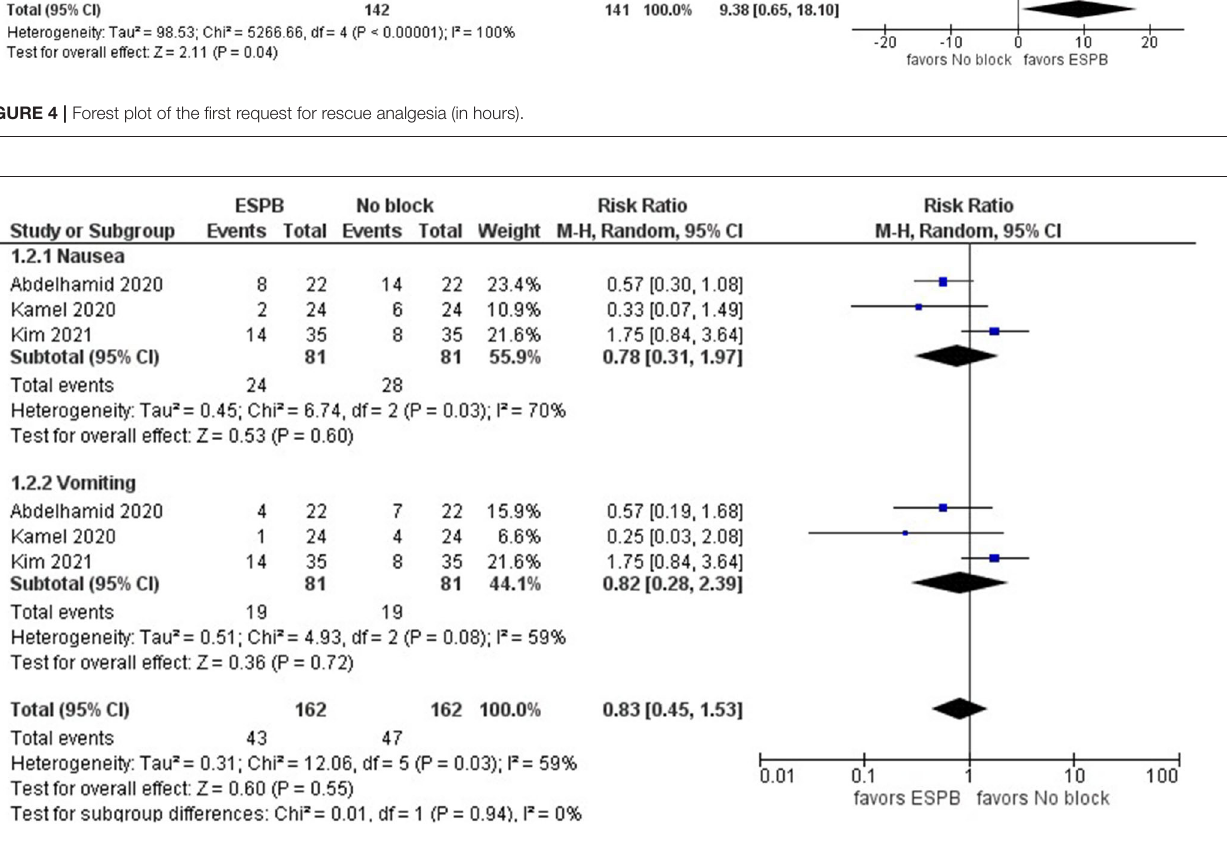
FIGURE 5 | Forest plot of postoperative nausea and